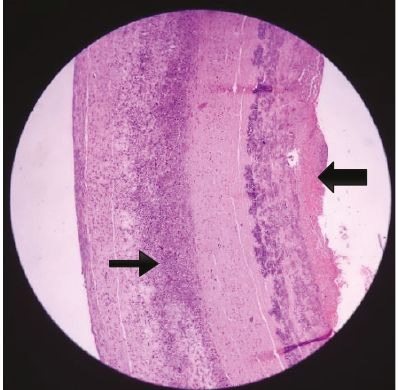
Figure 4: This is a section of the vascular wall adjacent to the main thrombus. Neutrophilic in fi ltrates (thin arrow) can be appreciated within the layers of the wall. At the intimal side, there is fi brin deposition (thick arrow) indicating an endothelial state favorable towards coagulation.